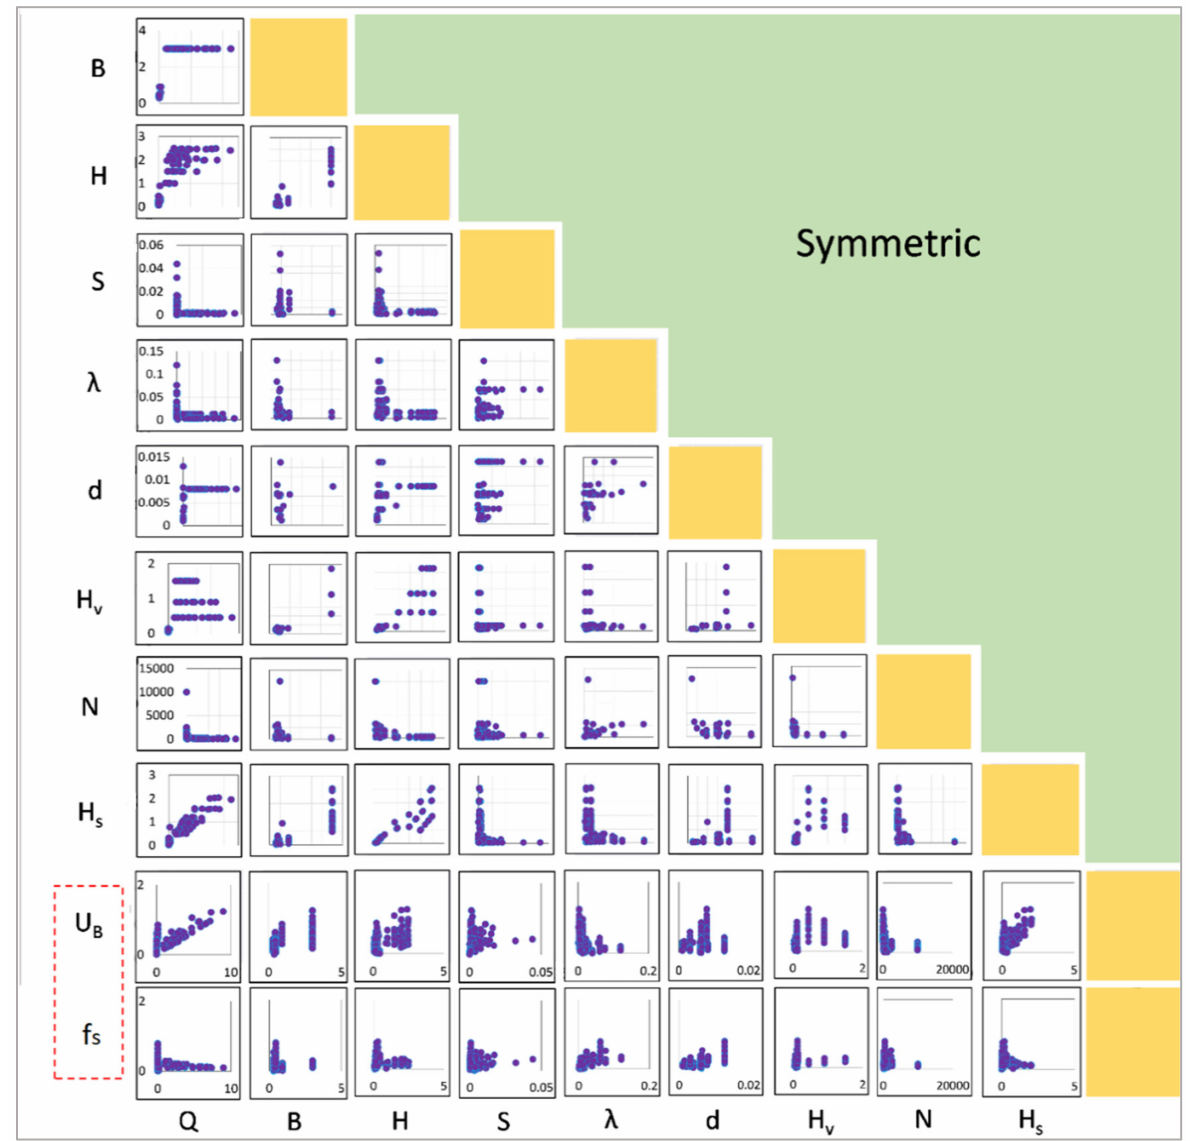
Figure 3. Pairwise correlation plot. (All of the variables’ (dependent and independent) parameters are plotted against each other. Labels are located at the bottom of the figure, and the scale denotes the x-axis for all boxes along their respective column. Labels are on the left, and the scale denotes the y-axis for all boxes along their respective